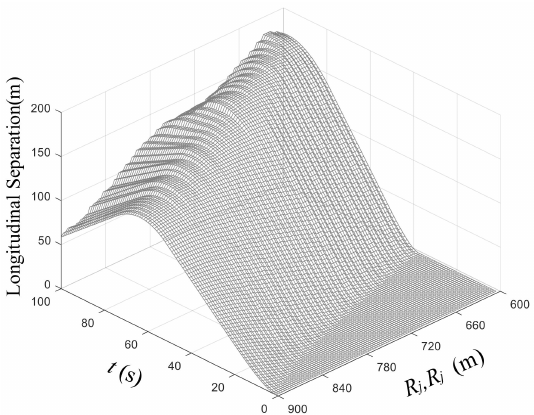
Figure 5. Trend Chart of Longitudinal Separation between Two Aircraft with Time and Visual